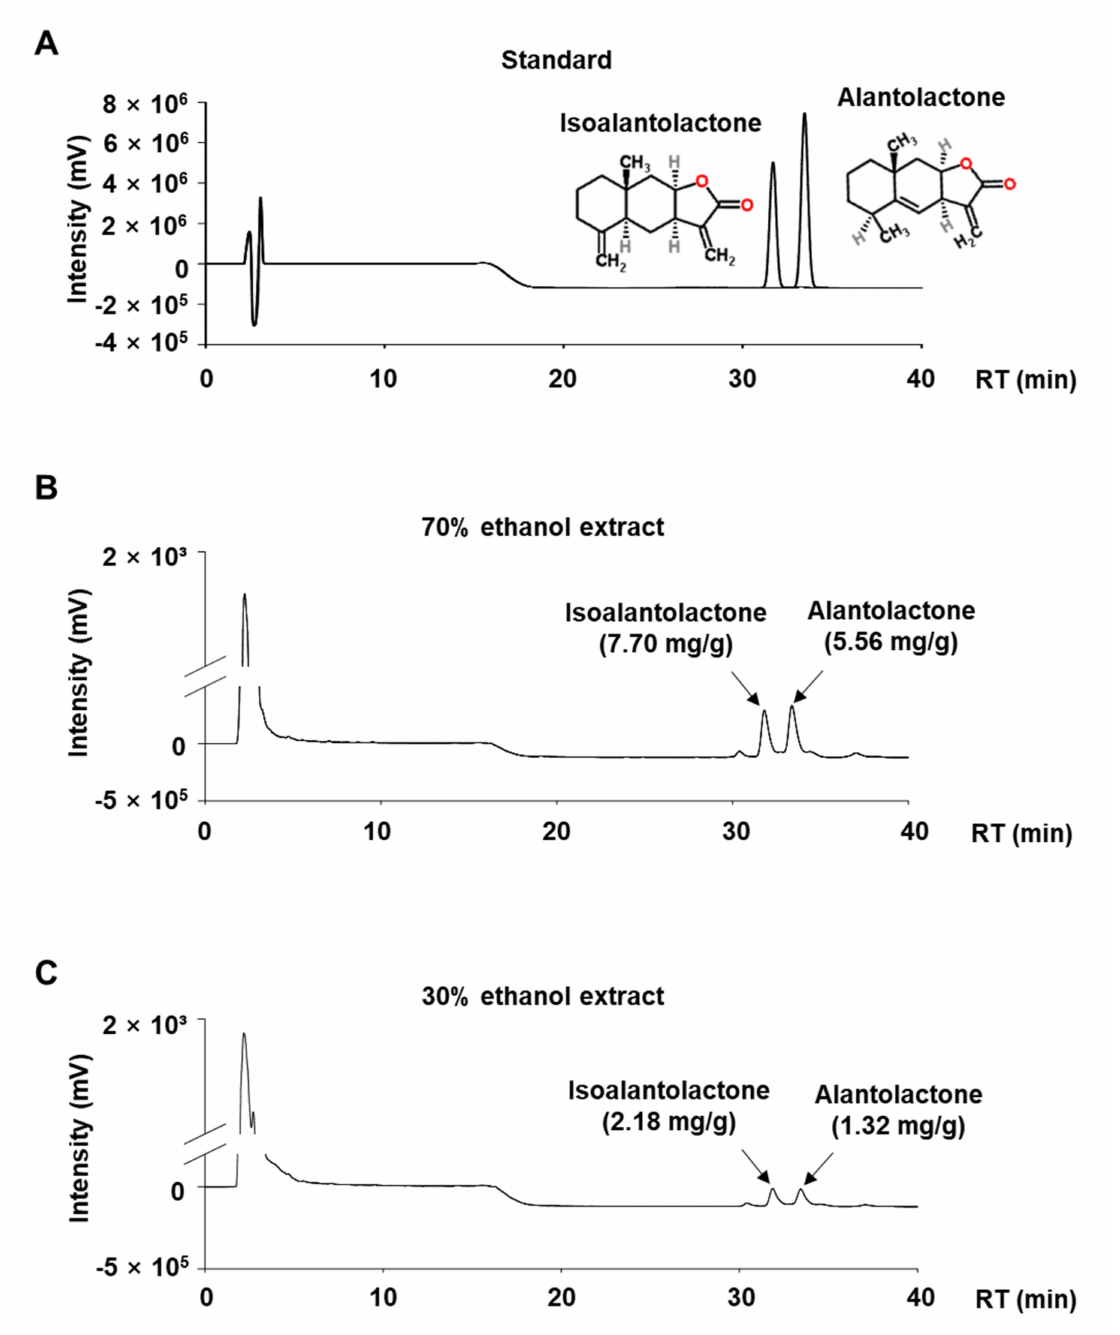
Figure 2. HPLC chromatograms of ISO and ALA in IHE. HPLC chromatograms of isoalantolactone and alantolactone standards ( A ), 70% ethanol extracts ( B ), and 30% ethanol extracts ( C ) of Inula helenium recorded at 220